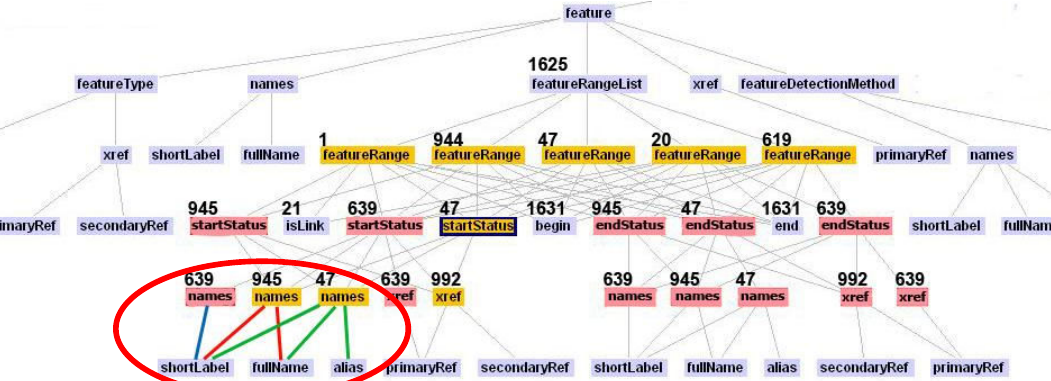
Figure 7: Summary refinement for featureRange , startStatus , endStatus , names , and